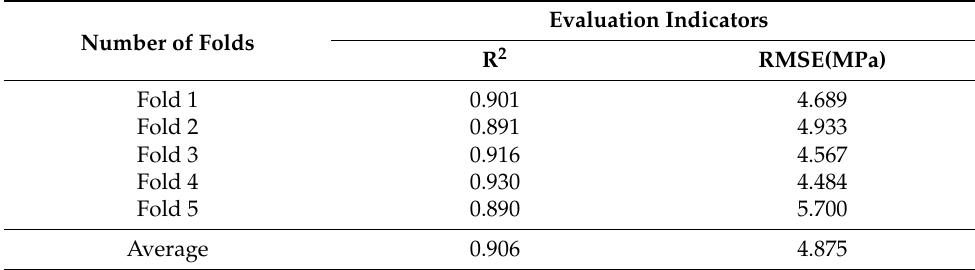
Table 9. Five-fold cross validation